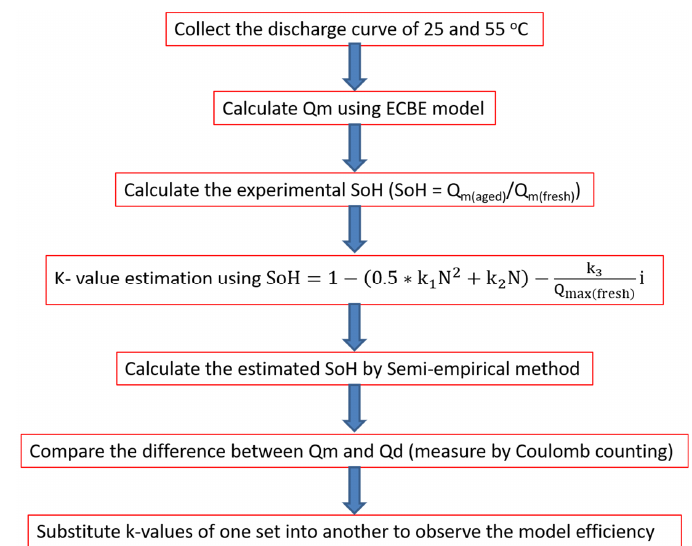
Figure 3. Flowchart for error estimation between experimental and estimated SoH.